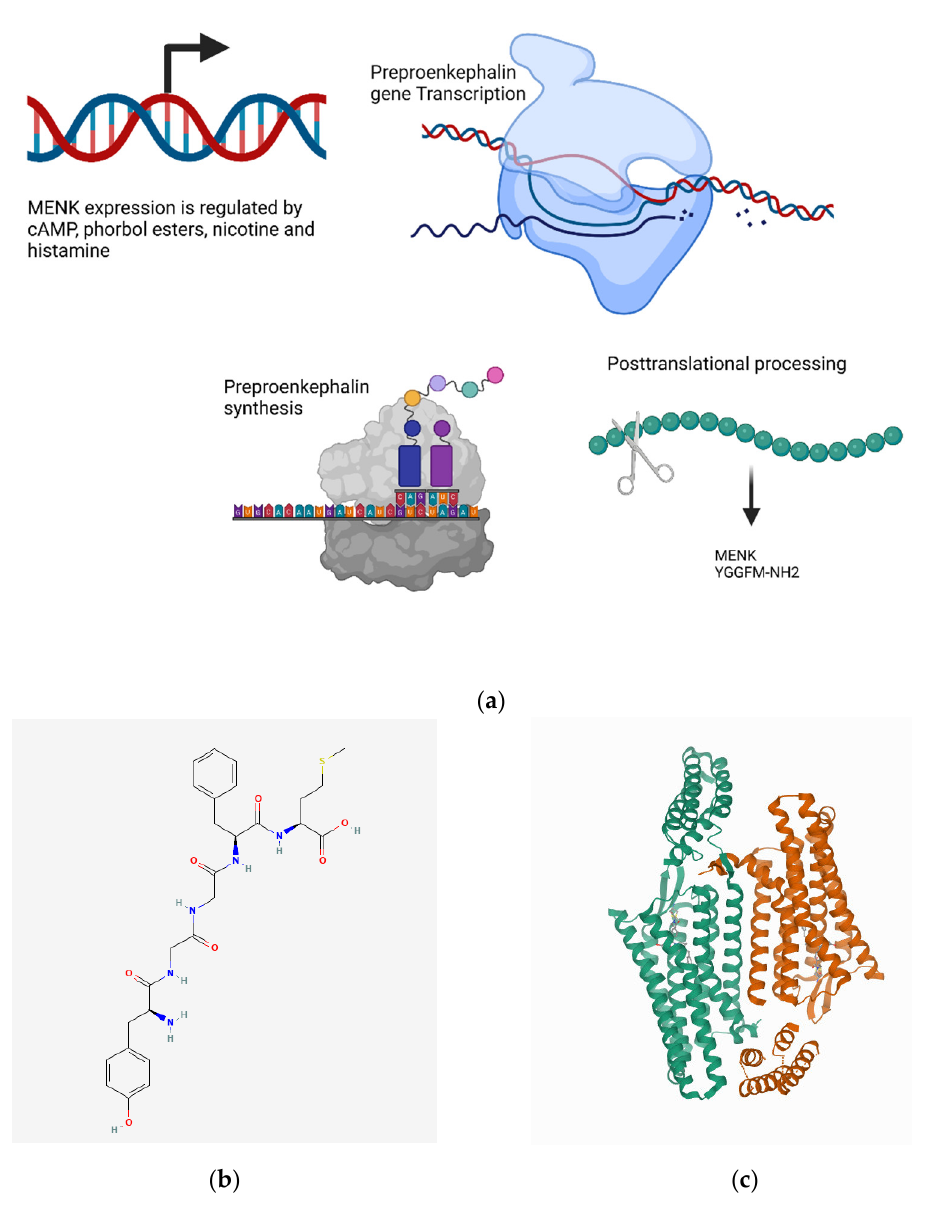
Figure 11. Neuropeptide MENK and opioid receptor: ( a ) transcription and synthesis of MENK (created with BioRender.com accessed on 22 October 2021); ( b ) 2D structure image of MENK (https://pubchem.ncbi.nlm.nih.gov/compound/443363#section=2D-Structure, accessed on 22 October 2021); ( c ) crystal structure of the active delta opioid receptor in the complex with the small molecule agonist DPI-287. Image from the RCSB PDB (rcsb.org) of PDB ID 6PT3 [553].